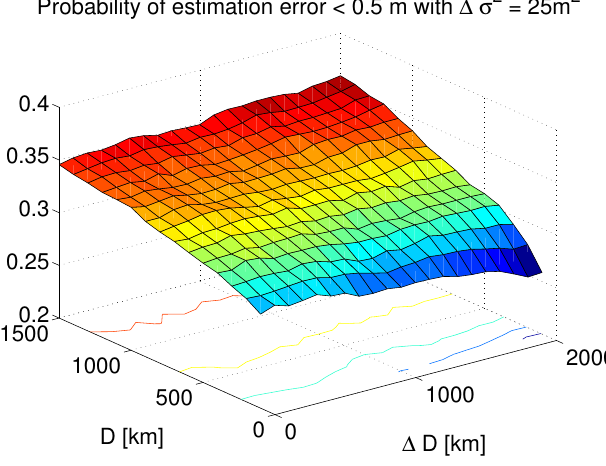
Figure 6. Probability of estimation error lying below half a meter for different correlation distance values and corresponding modeling